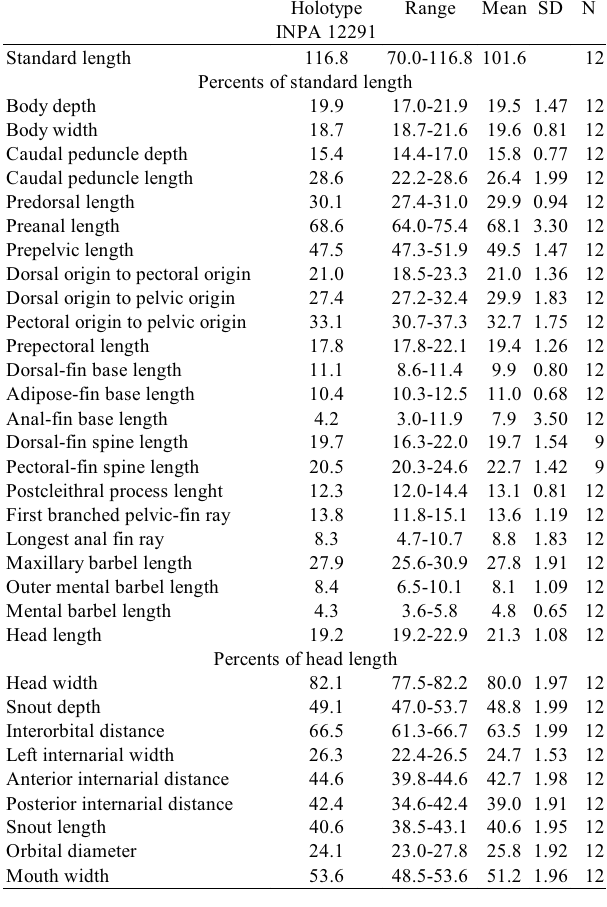
Table 12. Morphometric data for Tatia nigra . SD = standard deviation.